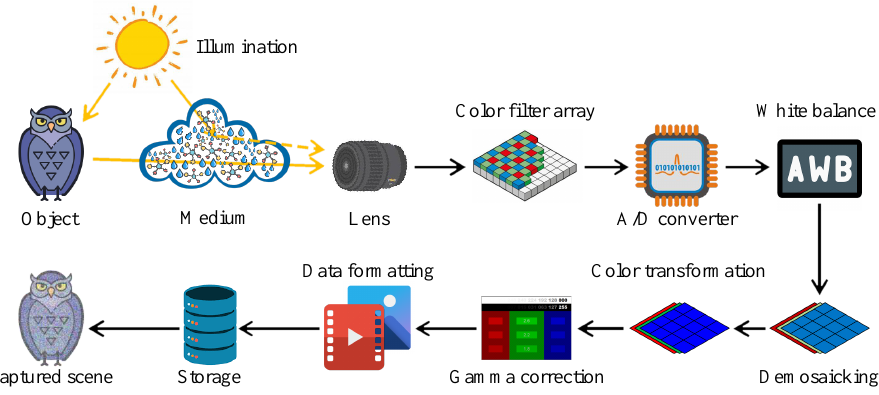
Figure 1. Typical example of digital camera